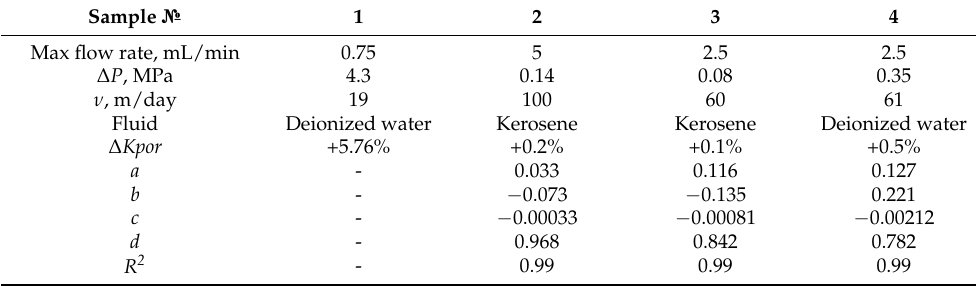
Table 3. Coreflooding conditions and calculated values of the coefficients of Equation